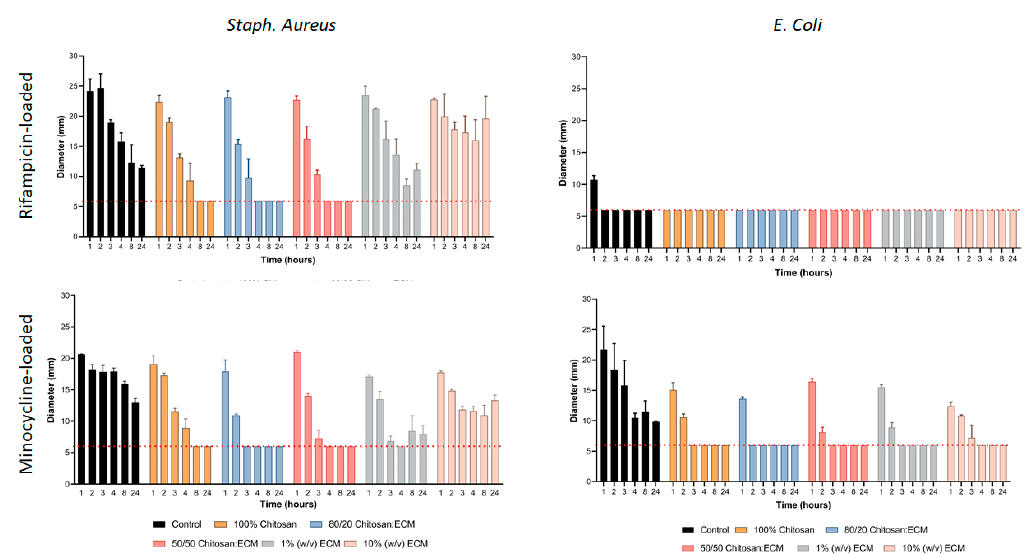
Figure 3. Graphs showing the duration of antimicrobial effects. Supernatant samples from the different scaffold formulations were taken at 1, 2, 3, 4, 8, and 24 h and incubated using a punch plate agar assay. Zones of inhibition were measure for both Staph. Aureus and E. Coli bacteria.